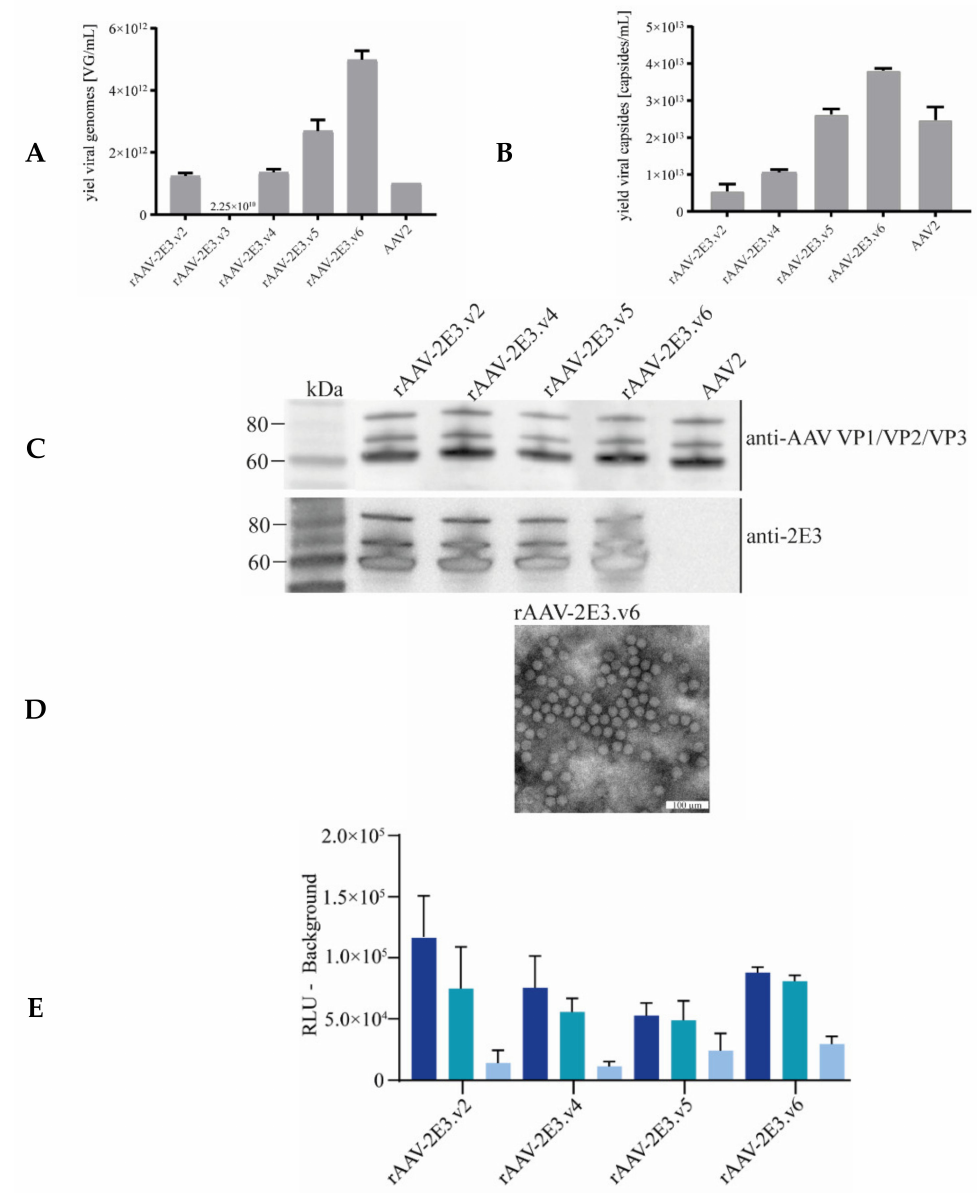
Figure 2. Production and characterization of rAAV-2E3 capsid variants. ( A ) Packaging efficiency of purified rAAV-2E3 particles (v2, v3, v4, v5, and v6) and AAV2. Experiments were performed in biological triplicates of each batch, and data are represented as mean + SD. ( B ) The vector yield of rAAV-2E3 variants and AAV2 was measured by ELISA. Experiments were performed in biological triplicates of each batch, and data are represented as mean ± SD. ( C ) Western blot and staining of reduced rAAV-2E3 variants and AAV2 with anti-VP antibody B1 (Progen, Heidelberg, Germany) or anti-2E3 antibody showing the presence of VP1:VP2:VP3 proteins and the insertion of the 2E3 epitope in all VP proteins of modified capsid variants. ( D ) Transmission electron microscopy of negative stained rAAV-2E3.v6 viral particles. Scalebar 100 µ m. ( E ) Immobilization of rAAV-2E3 serotypes and AAV2 following binding of anti-2E3 antibody in serial dilutions (1:1000 dark blue, 1:10,000 turquoise, and 1:100,000 light blue) and detection via Sulfo-tag labeled anti-human IgG in a MSD ® -ECL ELISA assay. Data represent mean + SD of three independent